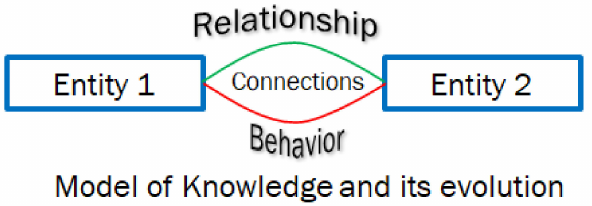
Figure 1. The fundamental triad is a knowledge structure derived from information.